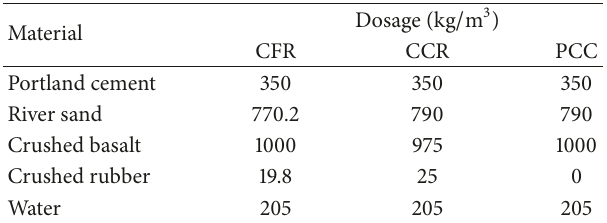
Table 1: Concrete mix